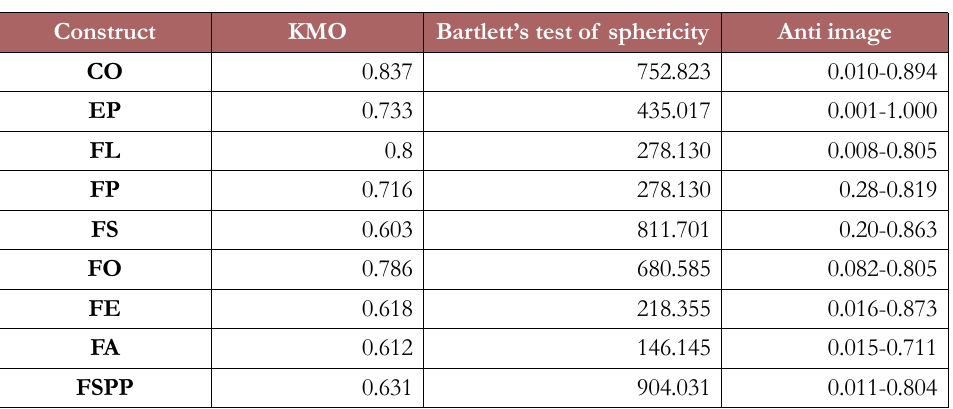
Table 3. Factorability of the EFA